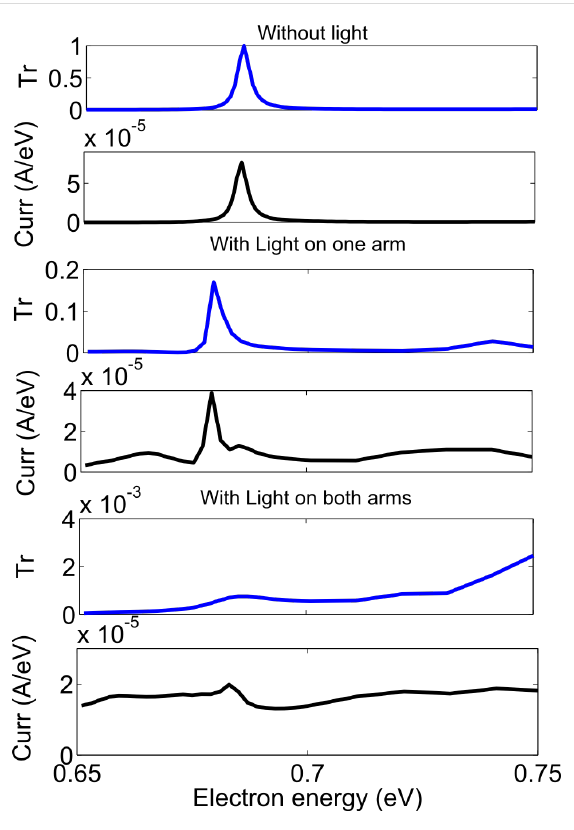
Figure 12: Transmittance and current density versus electron energy for a strong photon flux (armchair